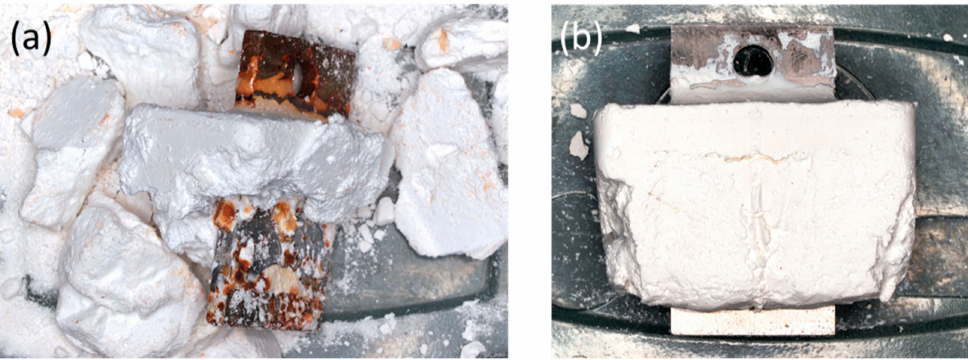
Figure 5. Example of an incompletely cured 1.8977/Wollastonite composite specimen. ( a ) Wollastonite mostly not hardened; ( b ) Wollastonite partially hardened.